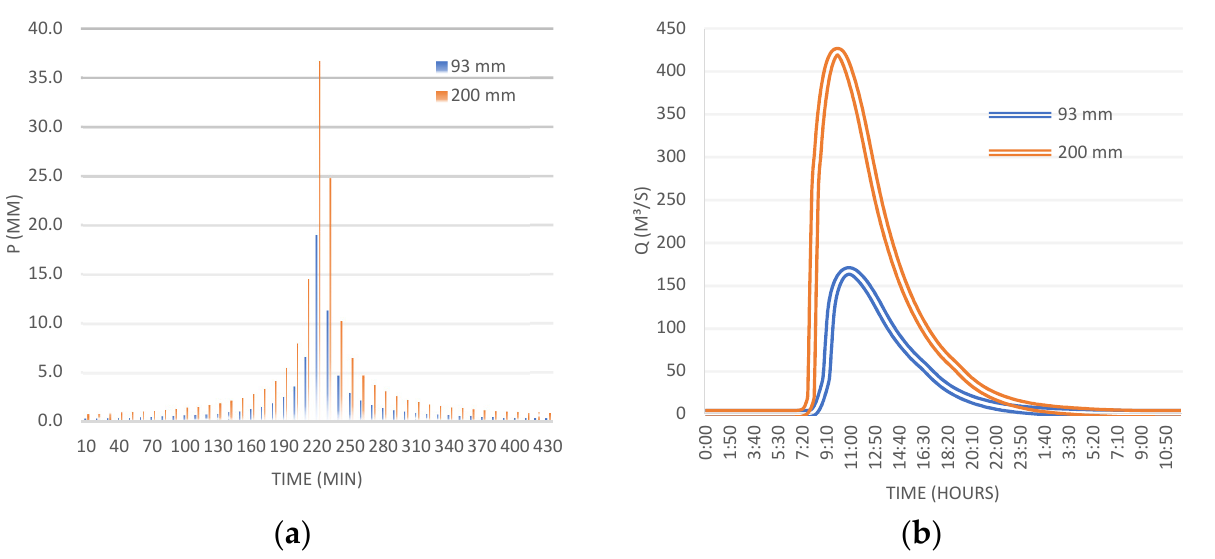
Figure 11. ( a ) Temporal distribution of rainfall by the alternating block method. ( b ) Hydrograph resulting from the modeling of scenario 01 in the HEC-HMS for 93 mm and 200 mm rainfall.